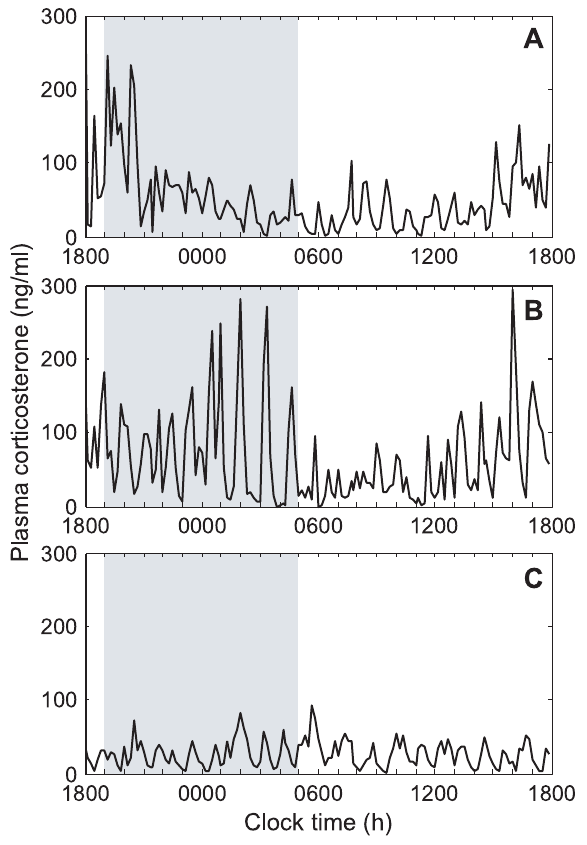
Figure 1. Ultradian glucocorticoid oscillations in physiological and pathophysiological states. (A–B) In basal (unstressed) condi- tions, diurnal variation in hormone levelsis not smooth but is reflected by a circadian modulation of ultradian pulse amplitude. Data shown is from female Sprague-Dawley rats (A) and female Lewis rats (B). (C) In male Piebald-Viral-Glaxo (PVG) rats with chronic inflammatory stress, pulse amplitude during the circadian nadir is comparable to pulse amplitude during the circadian peak. Shaded region indicates the dark phase.